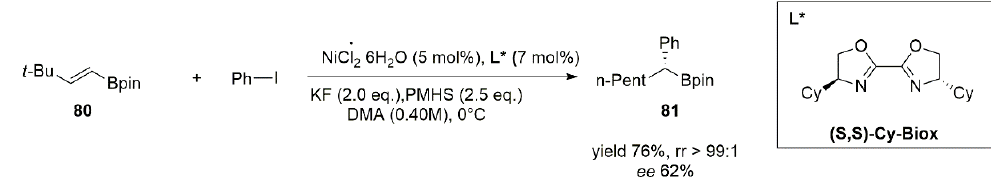
Figure 35 . Hydroarylation of boron containing alkene ( 80 ) and benzyl iodide by using Ni/(S,S)-Cy- Biox.